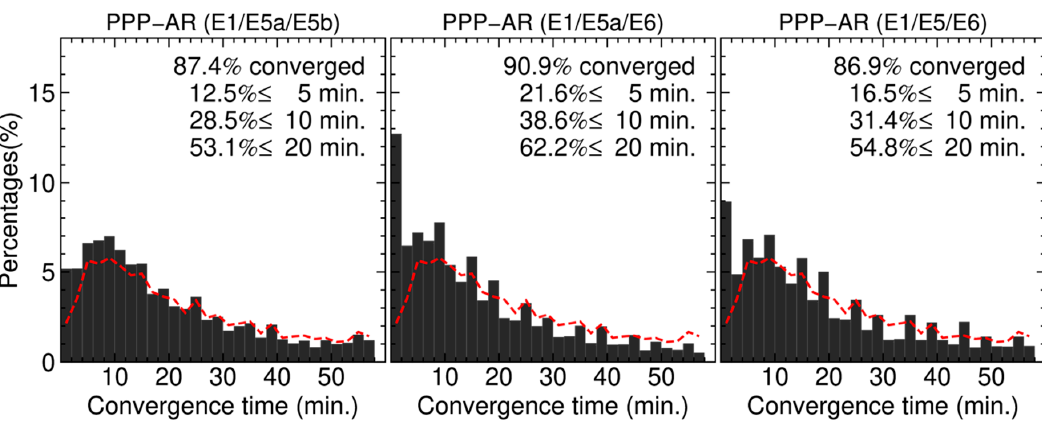
Figure 8. Statistics of the convergence time (minutes) of 15 selected stations’ triple-frequency (E1 / E5a / E5b, E1 / E5a / E6, and E1 / E5 / E6) PPP-AR with the pilot Galileo receiver antenna corrections. The percentage of the convergence and the percentages of the convergence time lengths shorter than 5, 10, and 20 min are shown in each subfigure. The red dashed lines represent the percentage distributions of the convergence time of dual-frequency (E1 / E5a)